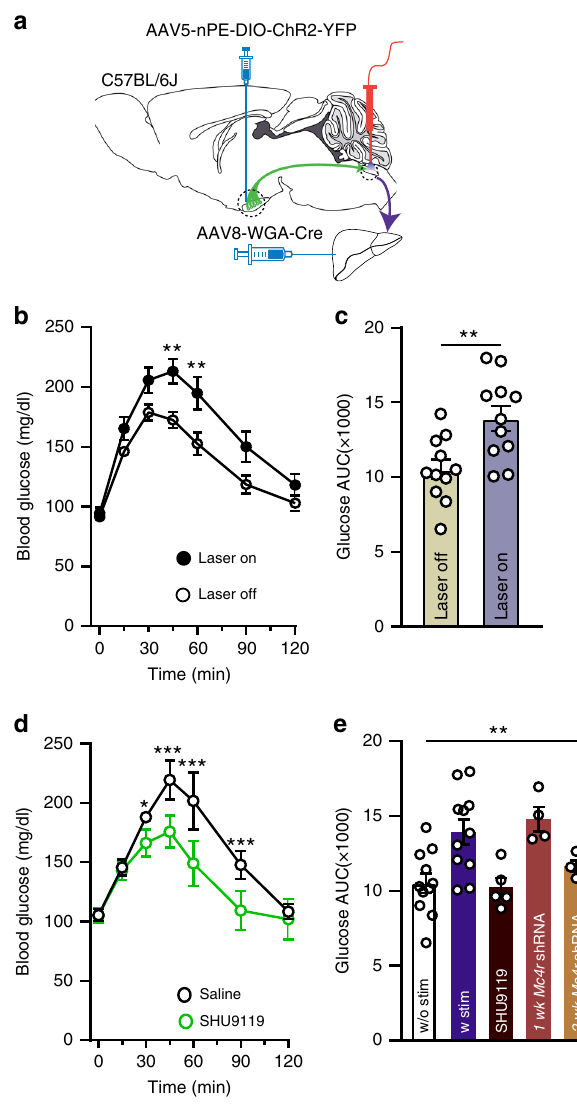
receptors in POMC neurons improves the effect of insulin on neurons also ameliorates hepatic insulin resistance 9,37 . Moreover, chemogenetic activation of the whole population of ARC POMC neurons lowers blood glucose levels that is associated with reduced Pepck and G6pase expression in the liver, whereas che- mogenetic inhibition induces the opposite effects on blood glu- cose and gluconeogenic enzyme expression 3 . In contrast to these fi ndings, it has been also shown that acute chemogenetic activa- tion of ARC POMC neurons does not in fl uence glucose meta- bolism 38 , while long-term inhibition of ARC POMC neurons lowers blood glucose 17 . This discrepancy may be due in part to heterogeneity of ARC POMC neurons in the context of the neurotransmitters, the receptors for hormones, nutrients, and neuropeptides, the neurophysiological responses, and importantly their distinct projection sites 2,3,8,39 . Due to this POMC neuron heterogeneity, it is dif fi cult to interpret the fi ndings from POMC transgenic and mutant mice. For example, acute stimulation of the whole population of ARC POMC neurons is not able to alter food intake 40,41 , despite the well-known anorectic effect of α - MSH. Surprisingly, POMC-speci fi c insulin receptor knock-in mice show exacerbated insulin resistance and increase HGP 36 .